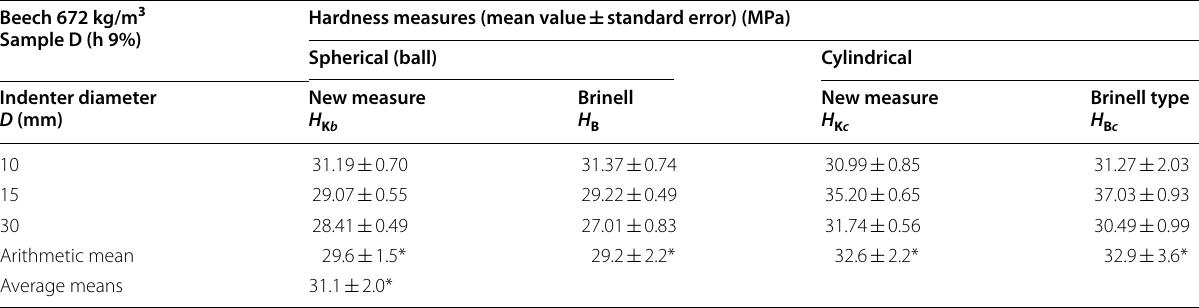
*Standard deviation of the type s m